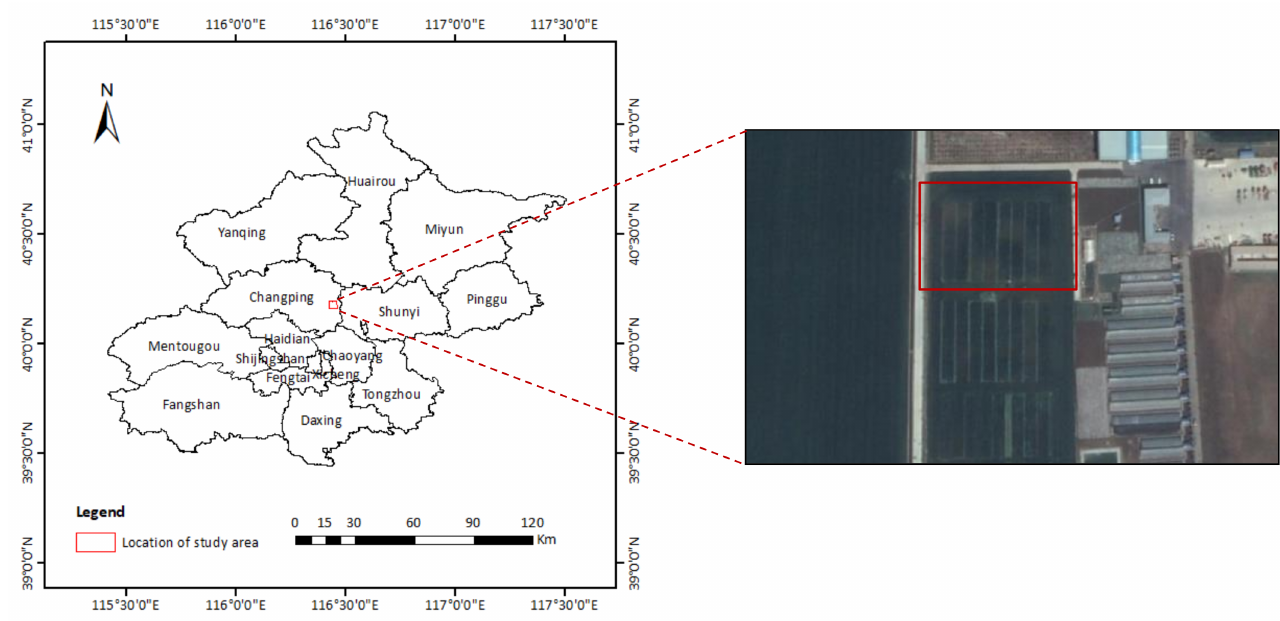
Figure 1. The location of the study